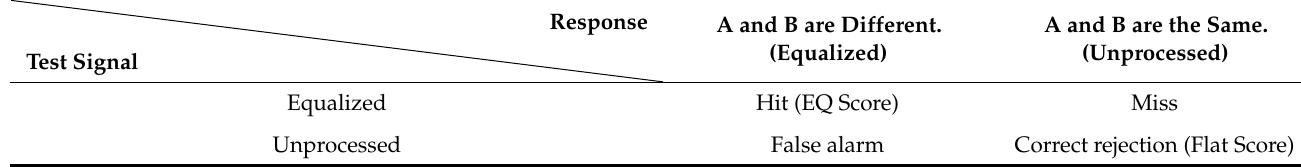
Table 2. Four types of events in the Yes-No